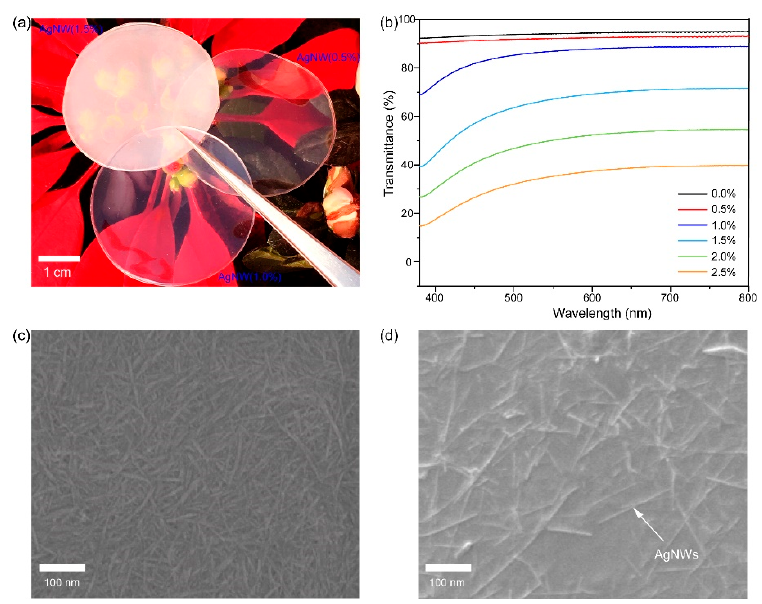
Figure 2. Optical properties of conductive paper: ( a ) Digital photograph of conductive paper with various AgNW contents; ( b ) optical transmittance of conductive paper; ( c ) SEM images of pristine CNF paper; ( d ) plasticized CNF/AgNW paper.